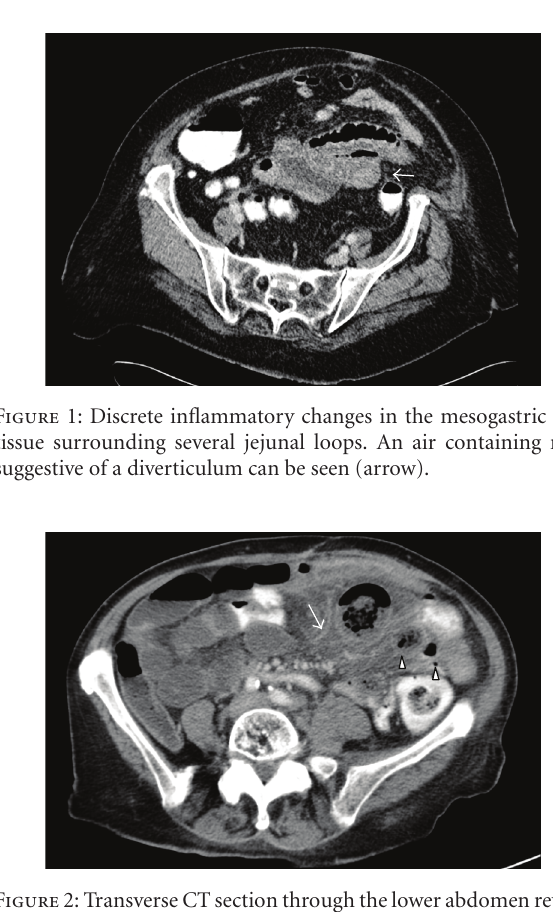
Figure 3: (a) Transverse CT section through the upper abdomen reveals localised inflammatory changes in the left upper quadrant (arrow) accompaigned by extraluminal air bubbles at the mesen- teric side of the jejunum (asterisk). (b) Small-bowel barium follow- through exam performed three weeks after the acute onset confirms the presence of multiple jejunal diverticula